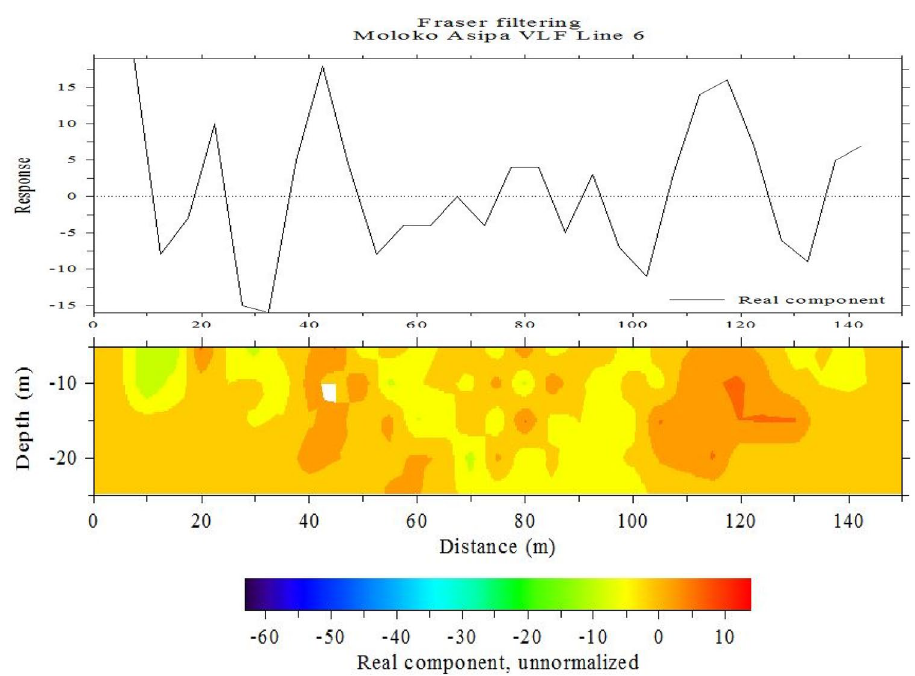
Fig. 7 Fraser and Karous–Hjelt representation for traverse